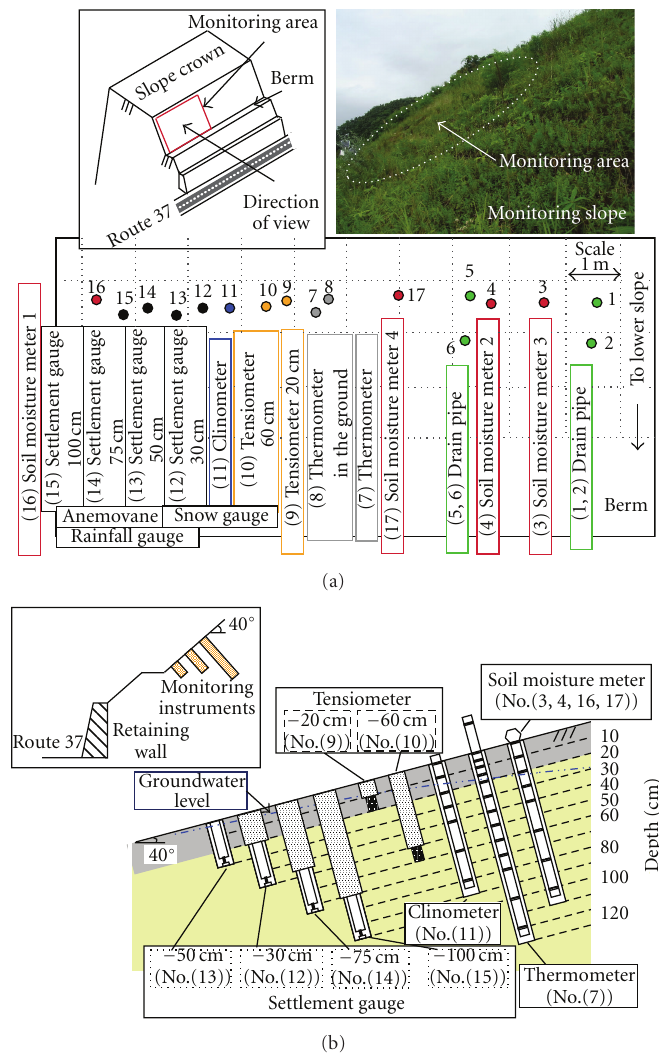
Figure 3: Setting positions of monitoring instruments; (a) plane section, and (b) cross section.